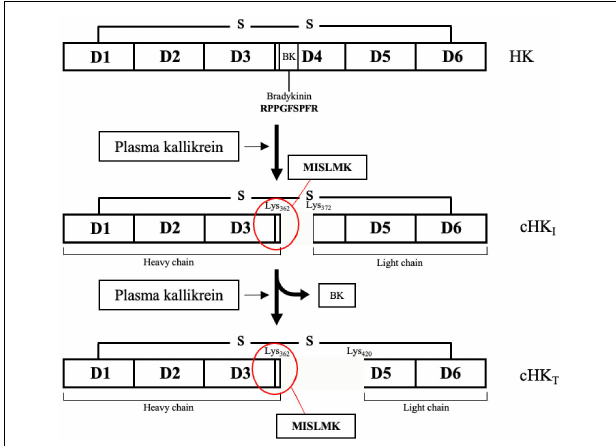
FIGURE 1 | The domain structure of H-kininogen (HK). HK is a single-chain structure consisting of six domains (D1-D6). D1-D3 comprises the heavy chain. Motifs on D4, containing the peptide bradykinin, link the light chain, comprising D5-D6, to the heavy chain. BK is released from HK after cleavage of HK by primarily plasma kallikrein (PKa) yielding an intermediate cleaved HK (cHK I ). After release of BK, the heavy and the light chain remain linked by a disulfide bond. A further cleavage of HK by PKa yields a truncated form of HK (cHK T ). Figure modified from Zhang et al.